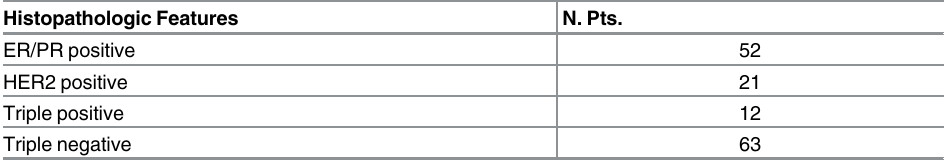
Table 2. Histopatologic features of malignant